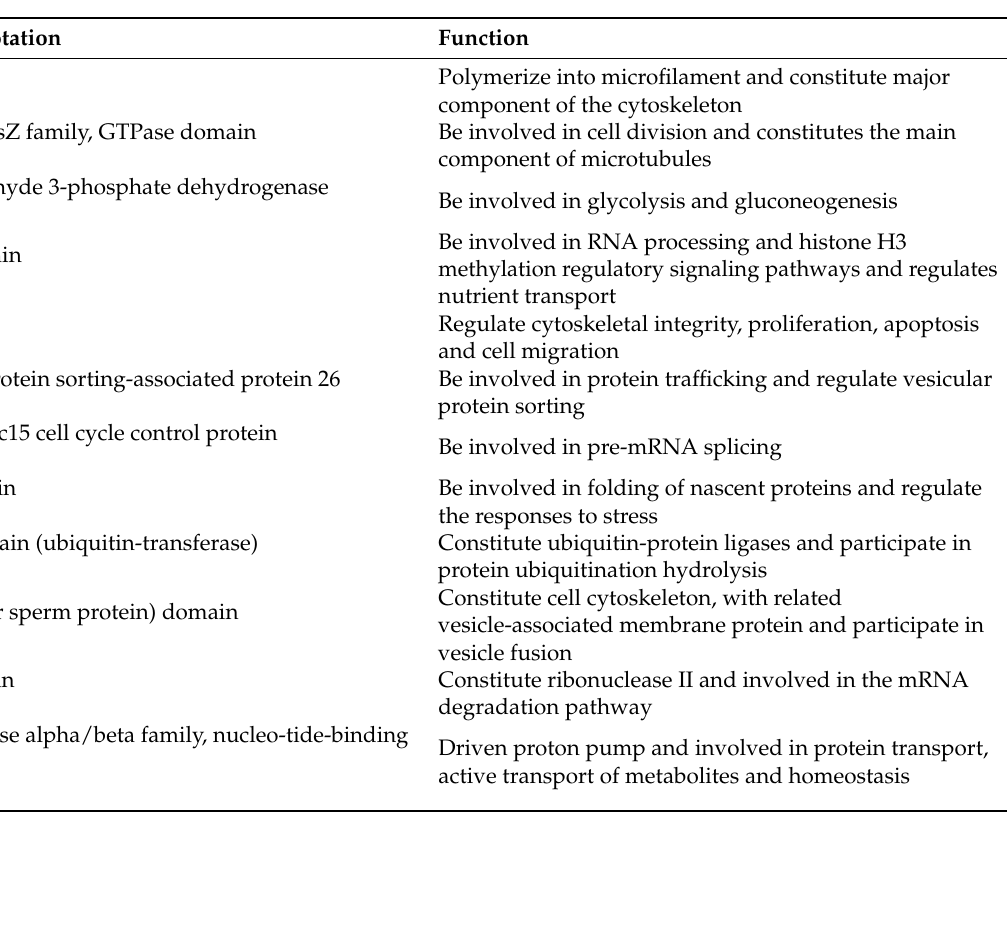
Table 3. The predicted function of the 12 reference